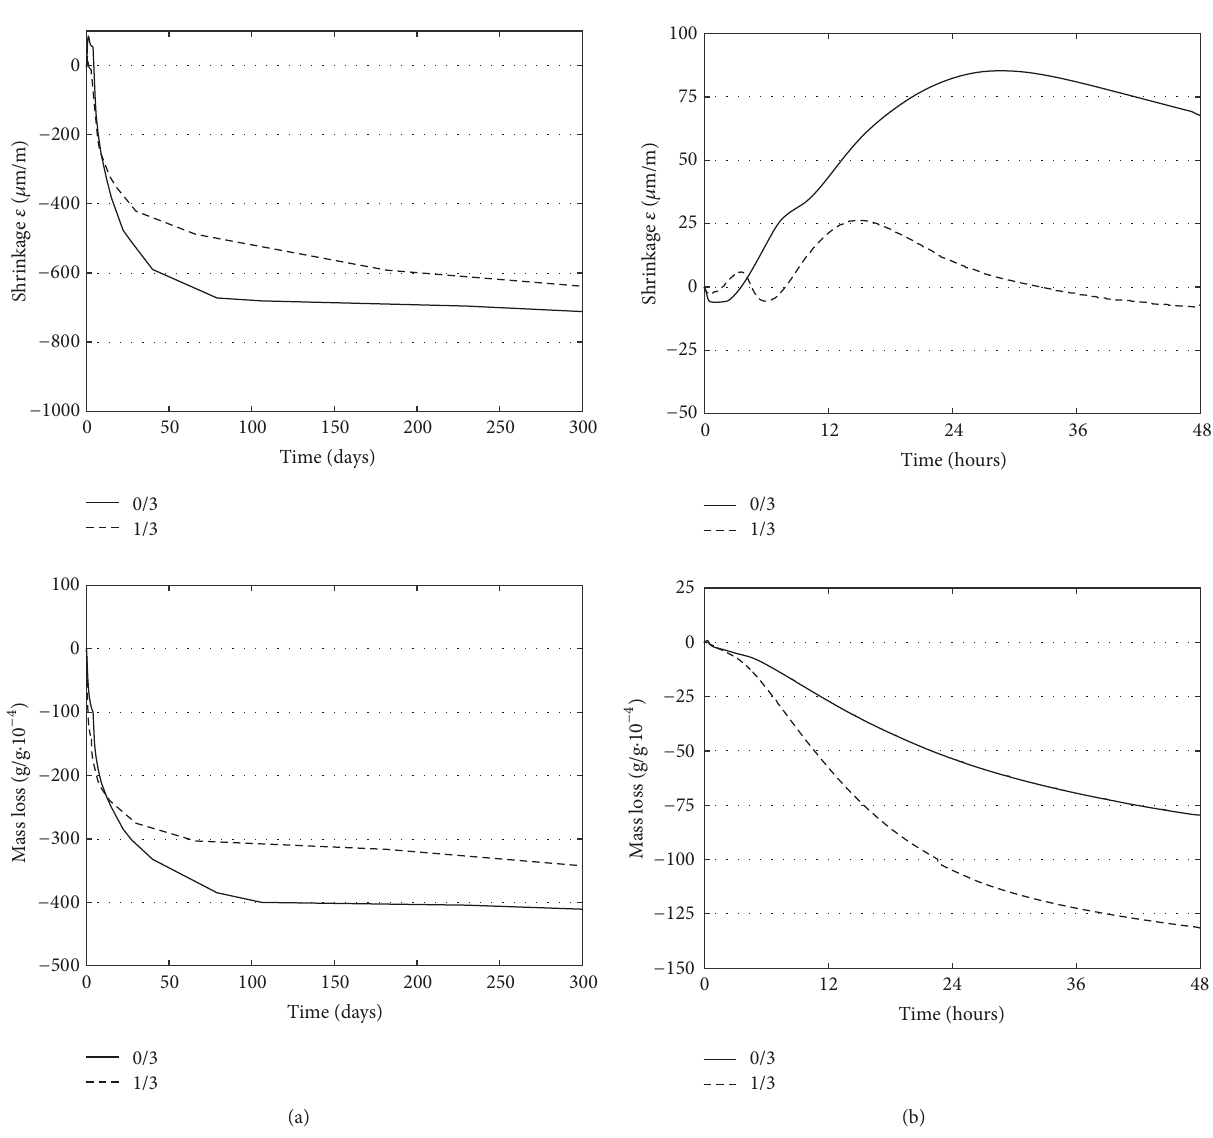
Figure 7: Progress of shrinkage/swelling and mass loss for concretes 0/3, 1/3, and ((a): measurement over the whole time of setting and hardening; (b): early age